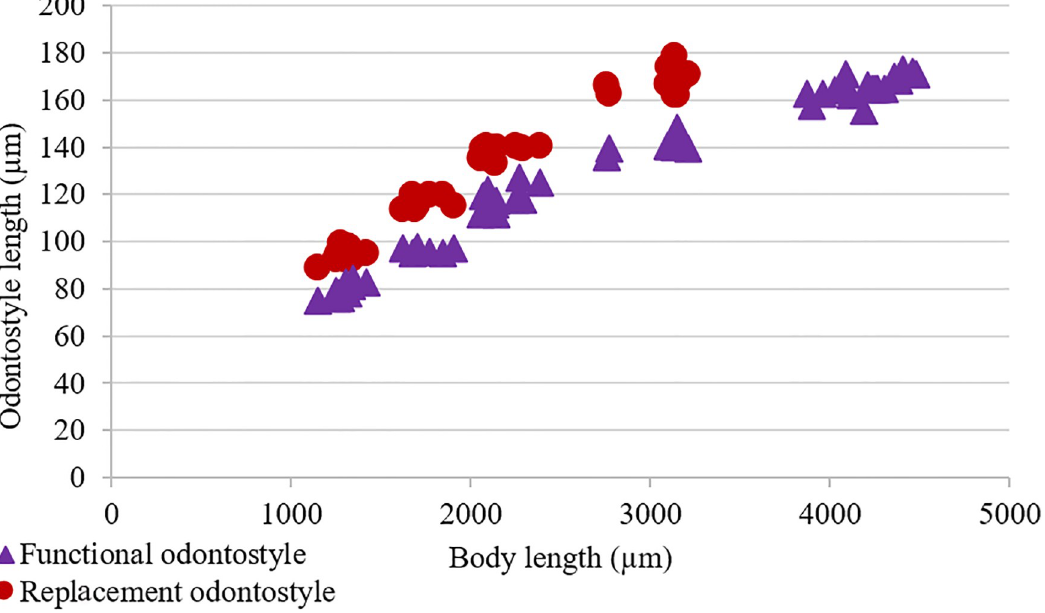
Fig 4. Relationship between body length and functional and replacement odontostyle length in all developmental stages from first-stage juveniles (J1) to mature females of Xiphinema afratakhtehnsis sp. nov. (type population, code: